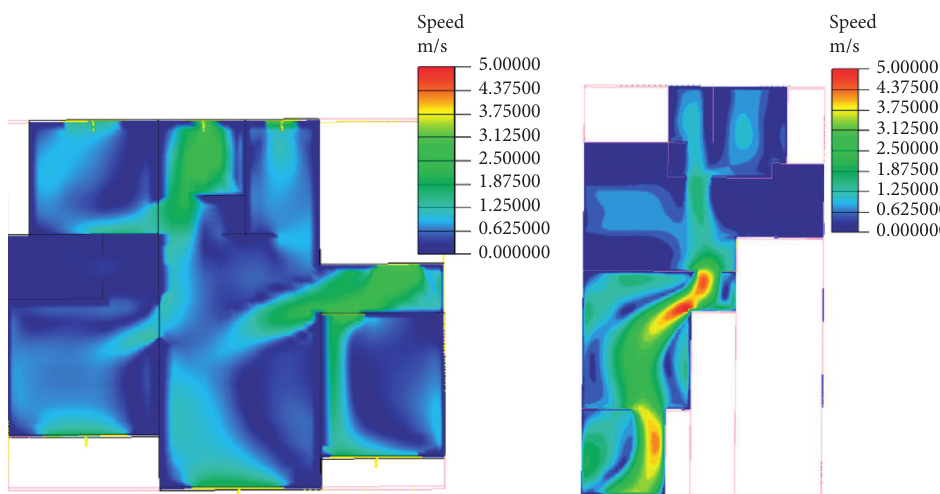
Figure 6: Speed distribution of two house types A and B under condition